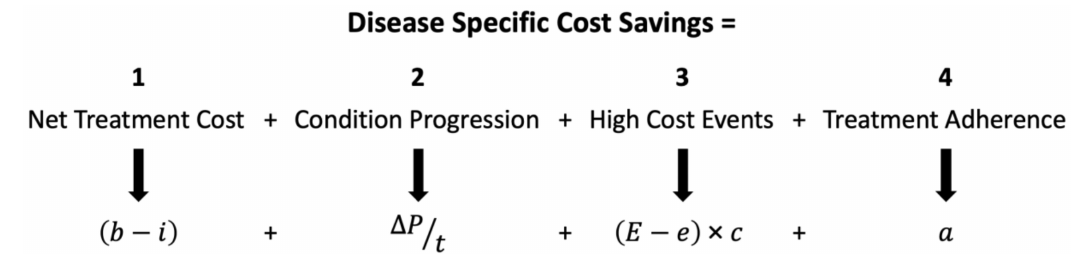
Figure 1. Equation for disease specific cost-savings estimate. Variable definitions by factor. Factor 1: b = all direct costs without condition specific treatment; i = all direct costs with a range from condition specific average treatment cost ( i 1 ) to cost-e ffi cient treatment ( i 2 ). Factor 2: ∆ P = P H − P L ; net cost of condition progression ( P H = all direct costs when treated high severity, P L = all direct costs when treated low severity); t = time of condition progression. Factor 3: E = high-cost event probability without condition specific treatment; e = high-cost event probability with condition specific average treatment; c = average high-cost event cost. Factor 4: a = treatment adherence savings. The resulting condition specific cost savings are per a ff ected patient, per